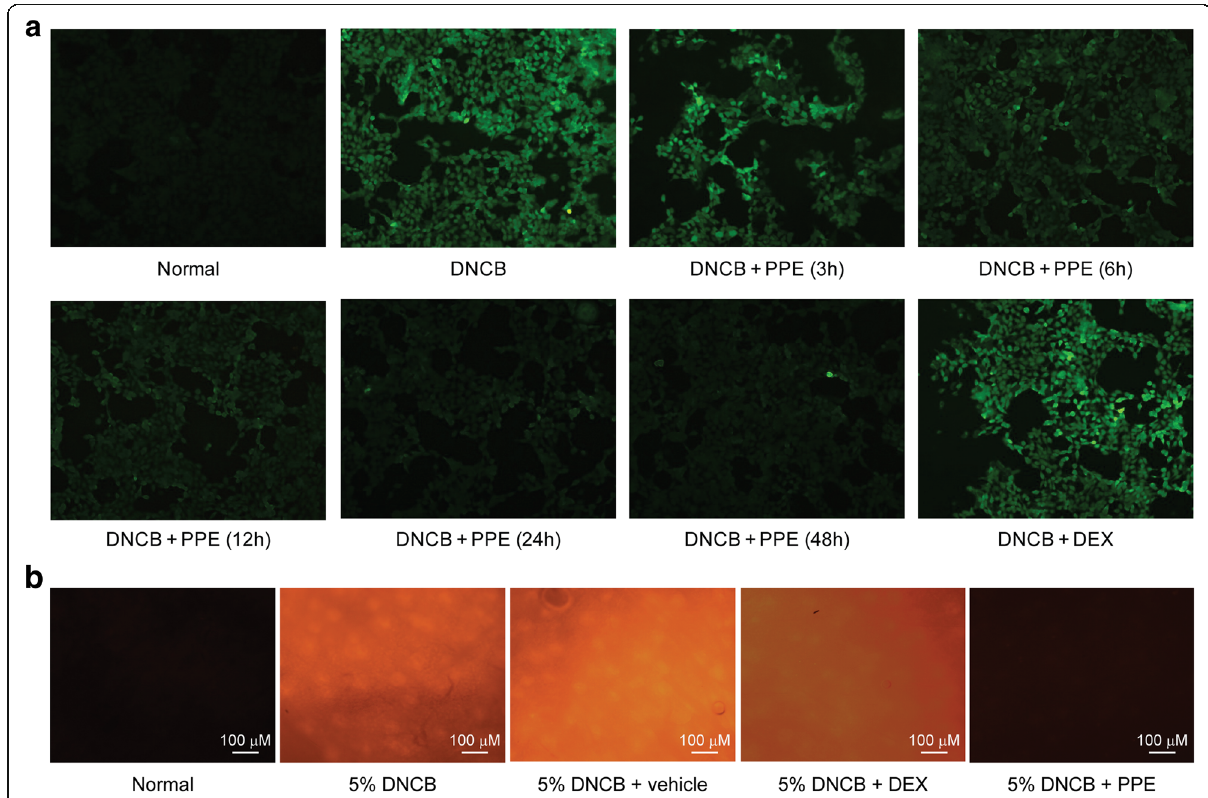
Fig. 4 In vitro and in vivo anti-oxidative activity of PPE on DNCB-induced ROS. ( a ) Cellular ROS production was induced by 40 μ M DNCB in HaCaT cells. To determine the effect of PPE on DNCB-induced ROS production, HaCaT cells were co-treated with DNCB and PPE for different time periods (3, 6, 12, 24 and 48 h). Intracellular ROS were stained with the H 2 DCFDA probe, and the fluorescence was visualized under a microscope. DNCB generated significant amounts of ROS in cells, which gradually disappeared with PPE treatment. After 48h of PPE treatment, fluorescence intensity diminished to the basal level (normal group). DEX did not display anti-oxidative activity after 24h of treatment. ( b ) Inhibitory effect of PPE on ROS generation in vivo. Ears of mice were pre-treated with cream (vehicle) alone, PPE or DEX in cream for 1 h before induction of ROS by topical application of 5% DNCB. Normal and 5% DNCB-treated groups were treated with PBS only or PBS with DNCB. Ear tissues were obtained after mouse euthanasia and stained ex vivo with 5mM DHE in DMSO for 30min. Fluorescence generated by ROS was visualized under a microscope. DNCB induced significant ROS production, which was almost completely abrogated by